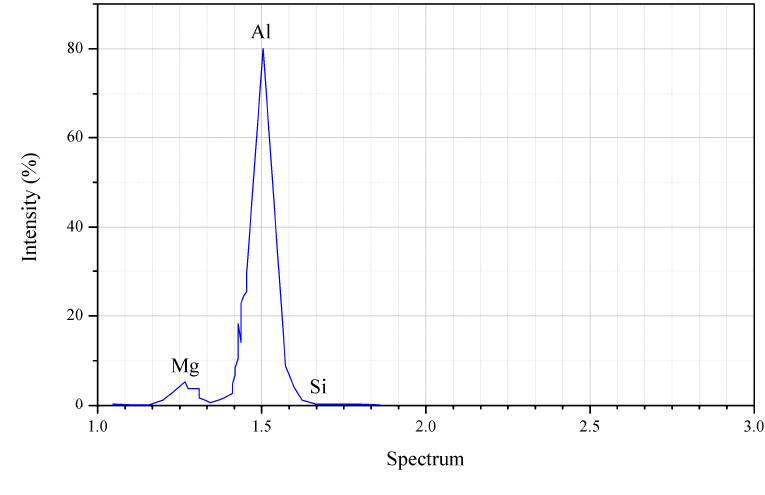
Figure 2. EDS spectra for AA6061 [23].